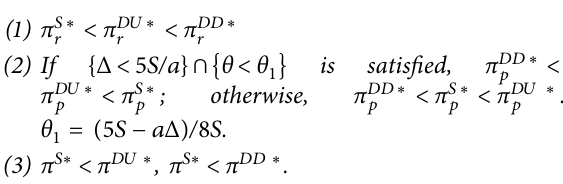
Figure 4: Comparison of optimal recycler’s profits among three